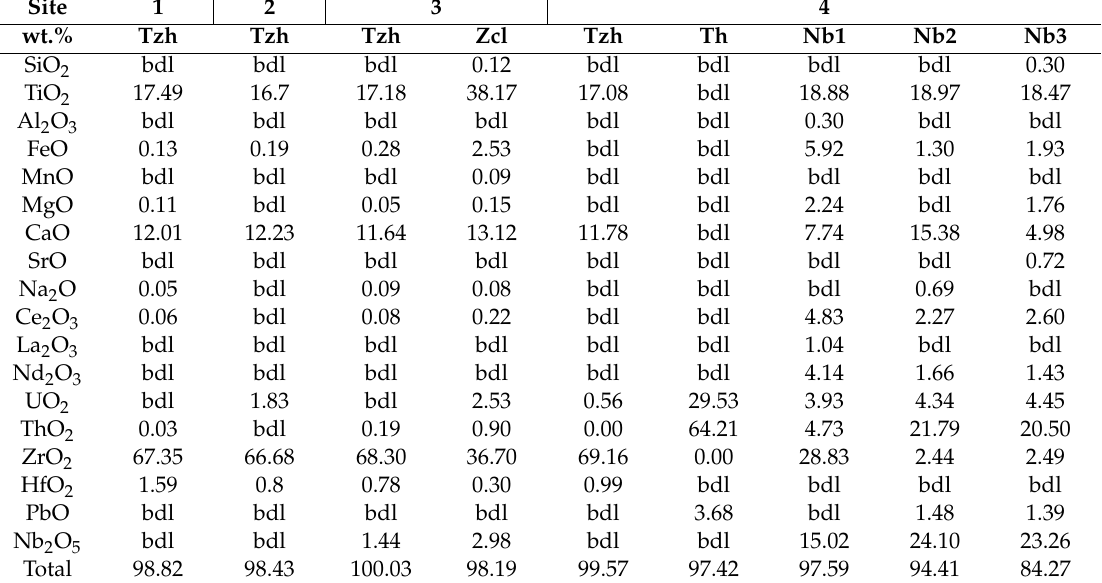
Table 3. Selected analyses of Ti-Zr-U-Nb minerals of the Tazheran